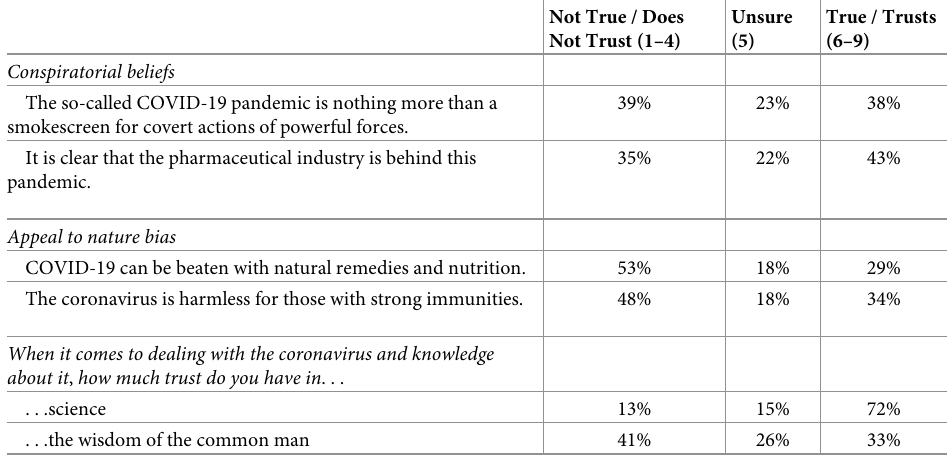
Table 5. Distribution of answers on the endorsement of epistemically suspect beliefs—Study 2.